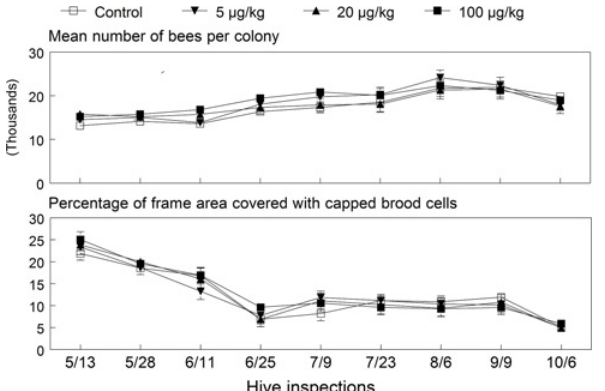
bees (dose: F (3, 26.7) = 0.99, p = 0.414; date: F (8, 281) = 75.25, p < 0.001; interaction: F (24, 281) = 1.13, p = 0.980; date: F p < 0.001; interaction: p = 0.311) and brood (dose: F (3, 25.9) = 0.06, (8, 279) = 68.27, p = 0.859). F (24, 279) = 0.69,